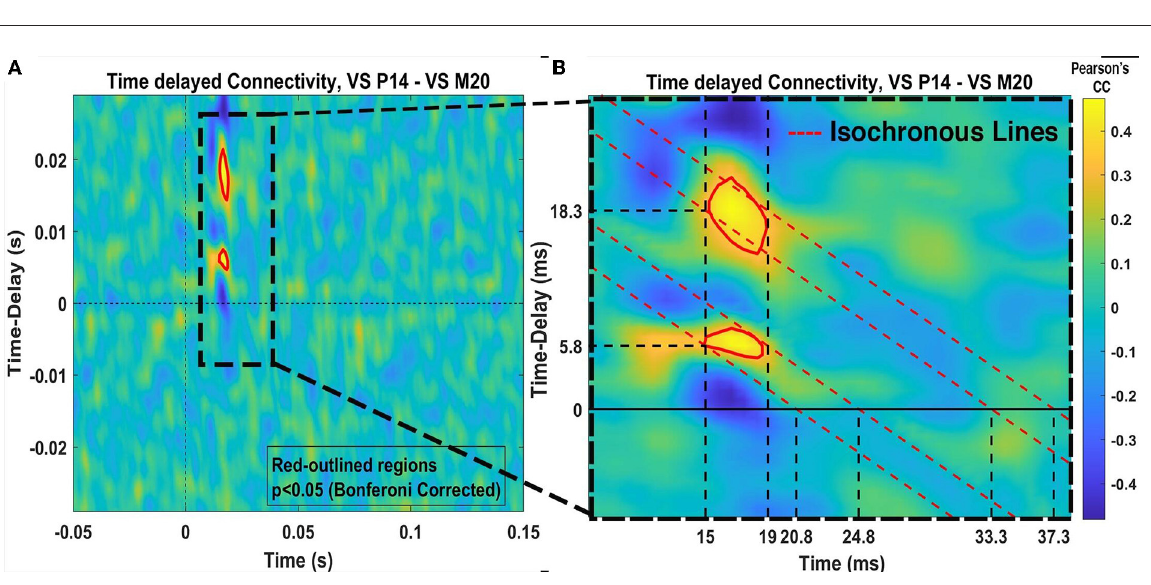
FIGURE9 Single trial functional connectivity results between VS signals P14-VS and M20-VS, for the trials belonging to Cluster 1 (81 trials) of the P14-VS (see Figure 7A). (A) Shows a color map with the correlation coefficient values at each time and time-delay. The red outlined areas show statistically significant values ( p < 0.05, Bonferroni correction). (B) Shows a zoom-in version of the figure in (A) , which shows in more detail the precise timing of start and end times of the statistically significant increases in connectivity